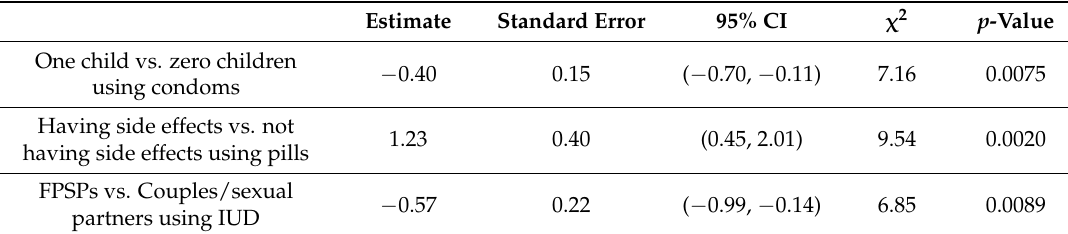
Table 4. ZINB analysis of interaction of informed choice correlated with induced abortions among immigrant women.